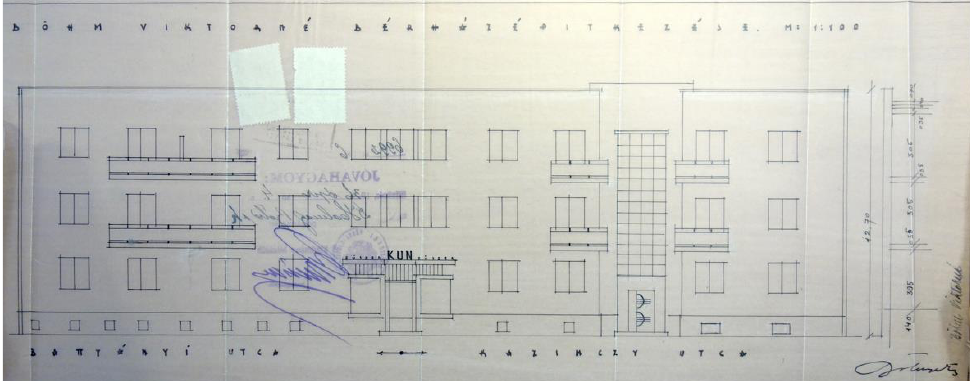
Figure 3. Original façade design of the 15a Kazinczy street (corner building: Batthány-Kazinczy street, Miskolc), two-story tenement house (still standing). Architect: Victor Bohm, 1936. Source: MNL BAZML IV.1906/b. 6992/1936.